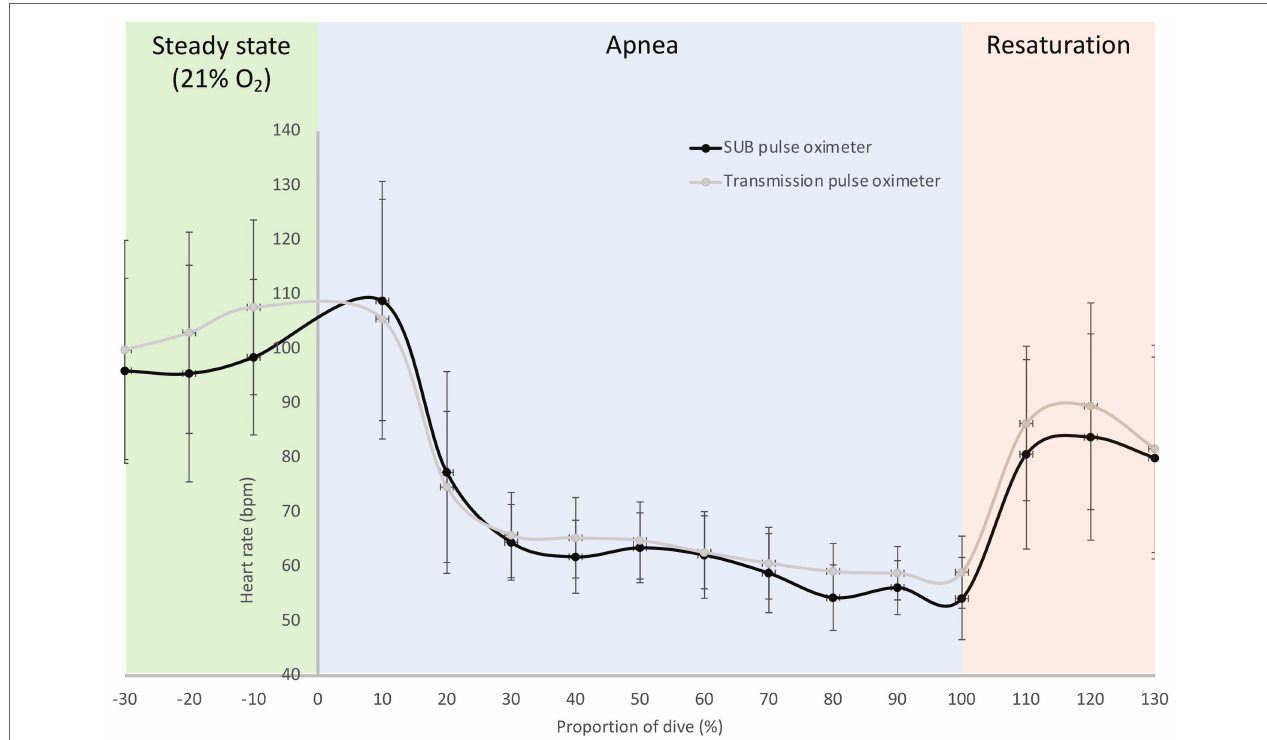
FIGURE 8 | Mean (SD) relative HR traces during a maximal breath-hold for the SUB pulse oximeter and the Lifesense transmission pulse oximeter; dive time is expressed as a percentage of the total dive duration (184 ± 53 s) for six